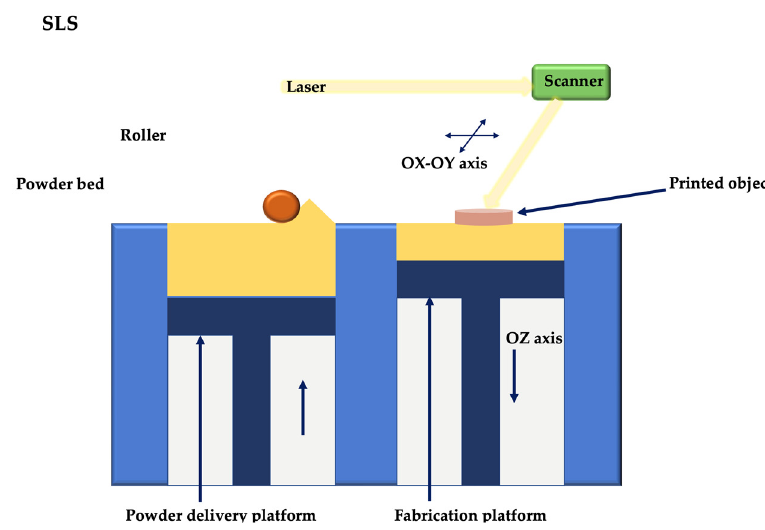
Figure 6. Selective laser sintering principle.